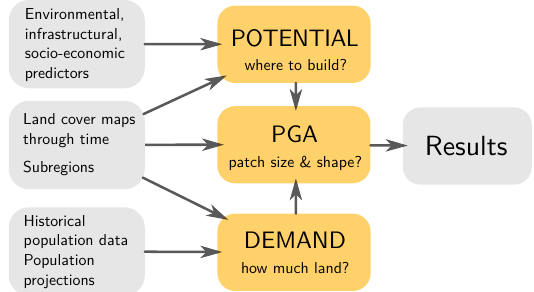
Figure 1: Simplified schema of FUTURES conceptual model with inputs and outputs in gray and submodels in